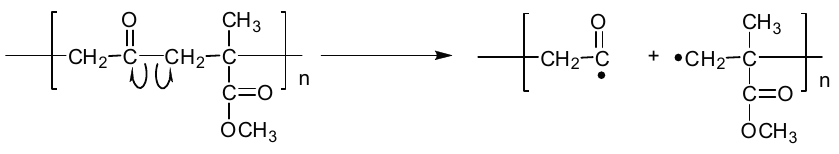
Figure 8. Formation of acyl radicals via degradation of the main polymeric